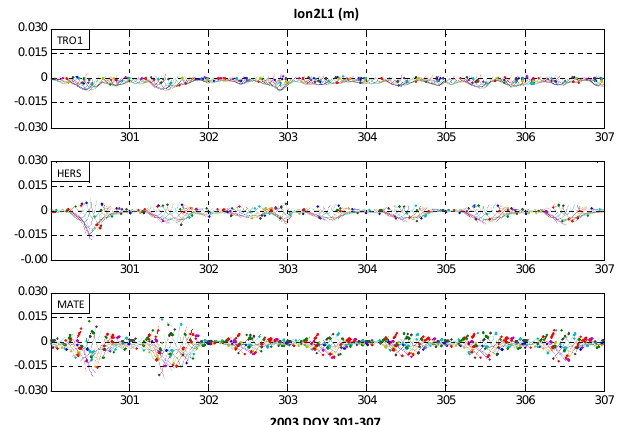
Fig. 7. Ion3 (m) for GPS L1 (Ion3L1) for the observation stations on DOY 294‐296 in 2001.